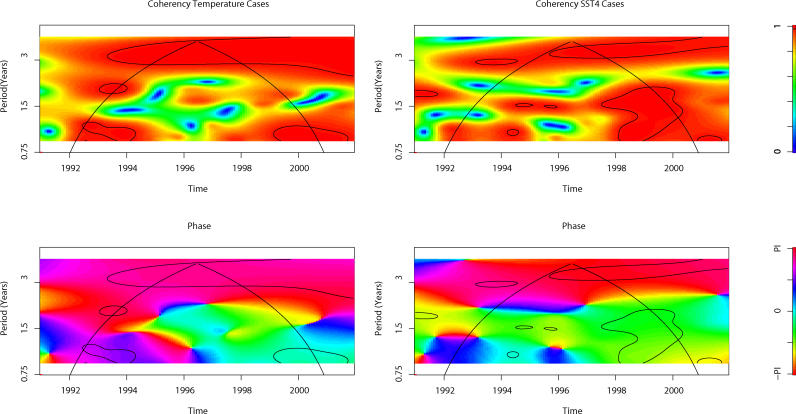
Cross-Wavelet Coherency and PhaseThe coherency scale is from zero (blue) to one (red). Thus, red regions indicate frequencies and times for which the two series share variability. The cone of influence (within which results are not influenced by the edges of the data) and the significant (p < 0.05) coherent time-frequency regions are indicated by solid lines. The colors in the phase plots correspond to different lags between the variability in the two series for a given time and frequency, measured in angles from −PI to PI. A value of PI corresponds to a lag of 16 mo. Cases are square-root-transformed. The procedures and software are those described in [21]. A smoothing window of 15 mo (2w + 1 = 31) was used to compute the cross-wavelet coherence.